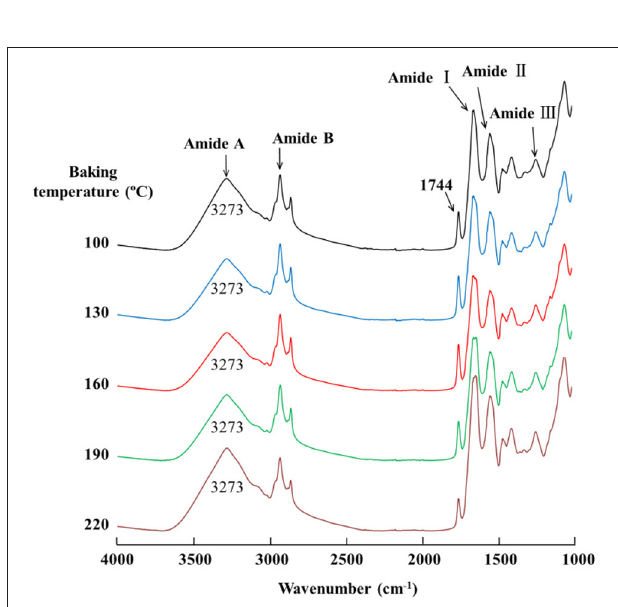
FIGURE 3 | FTIR spectra of eel burgers baked at various